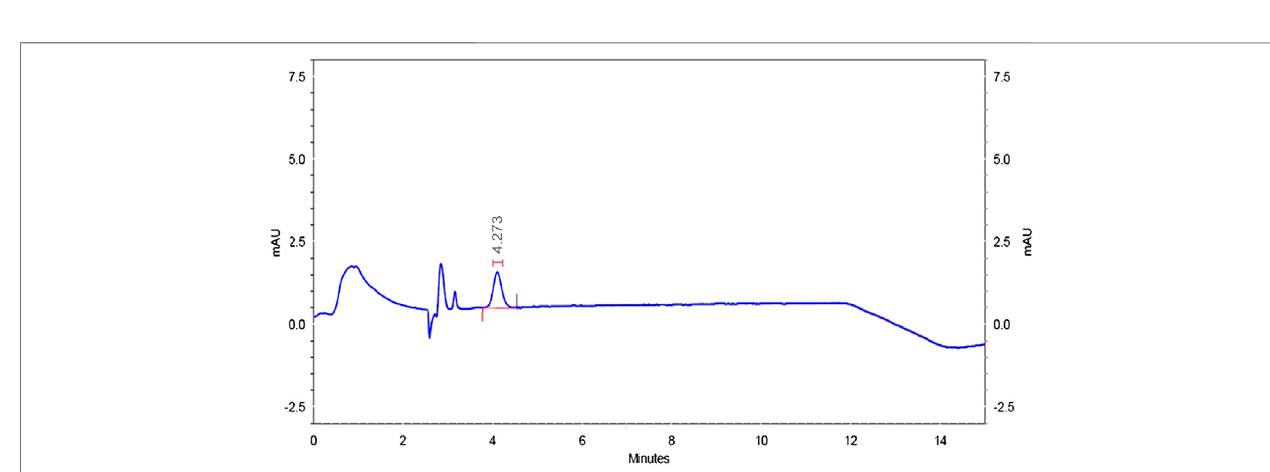
FIGURE 11 | Representative chromatogram of the fl umioxazin test item in basic water.